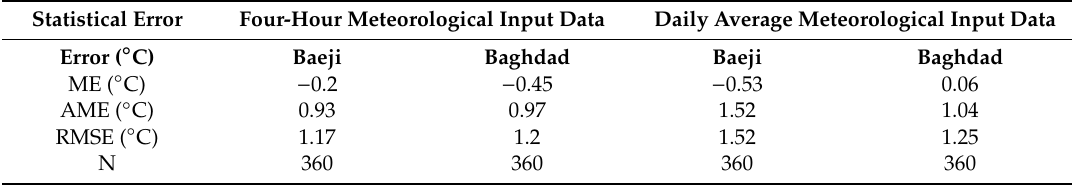
Figure 7. Diurnal variability in model predictions of T w at Baeji and Baghdad. Table 4. Statistical errors in daily average model predictions of T w .